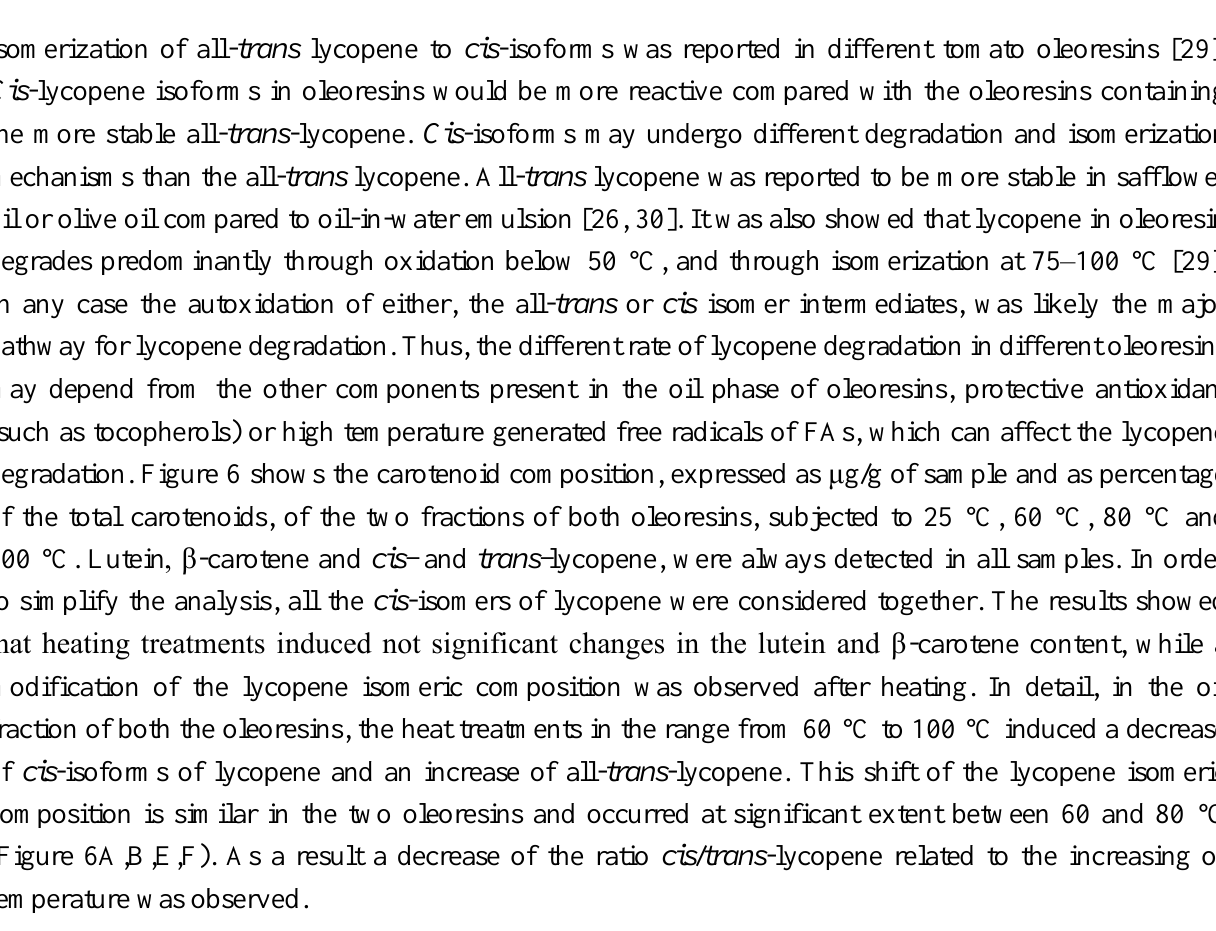
ExT, extracted from pure tomato 2 ExTH extracted from tomato/hazelnut 2